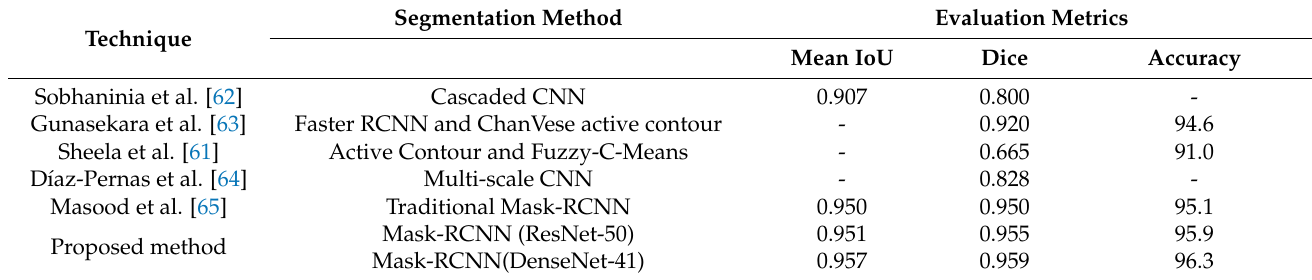
Table 3. Comparison of the presented method with other segmentation